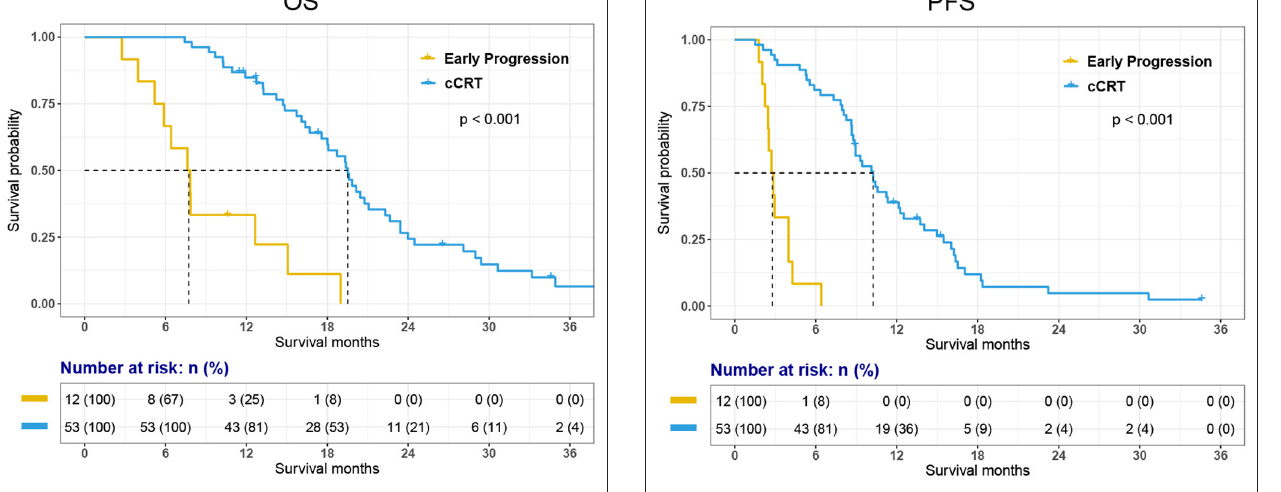
FIGURE 2 | Kaplan-Meier curve for Overall Survival (OS). FIGURE 3 | Kaplan-Meier curve for Progression-Free Survival